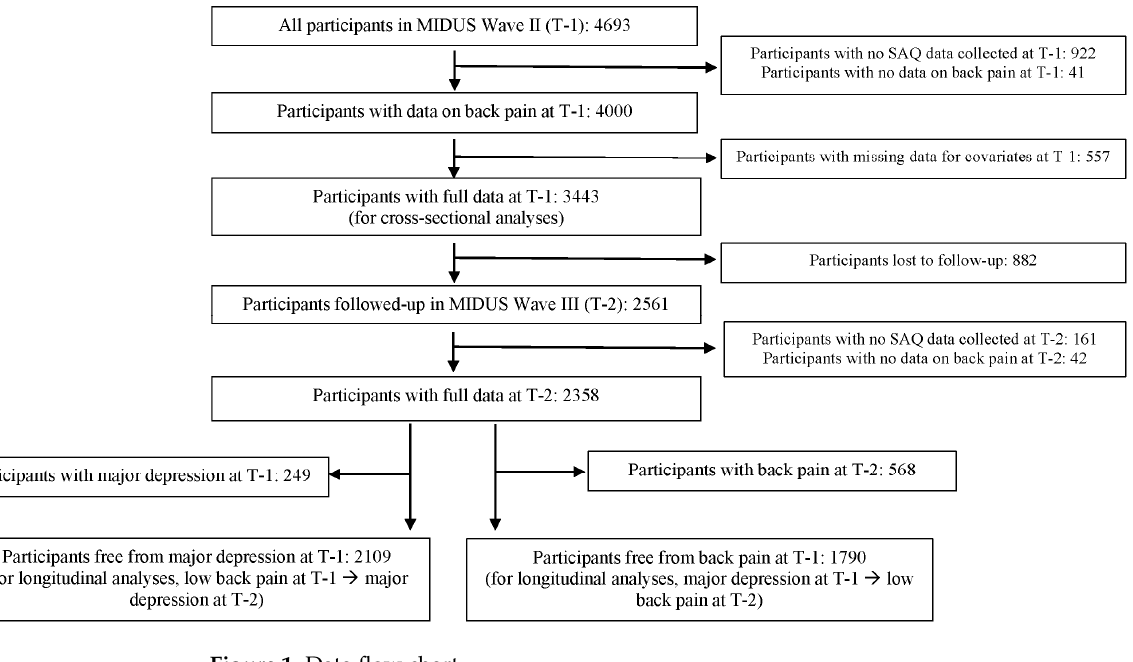
Figure 1. Data flow chart